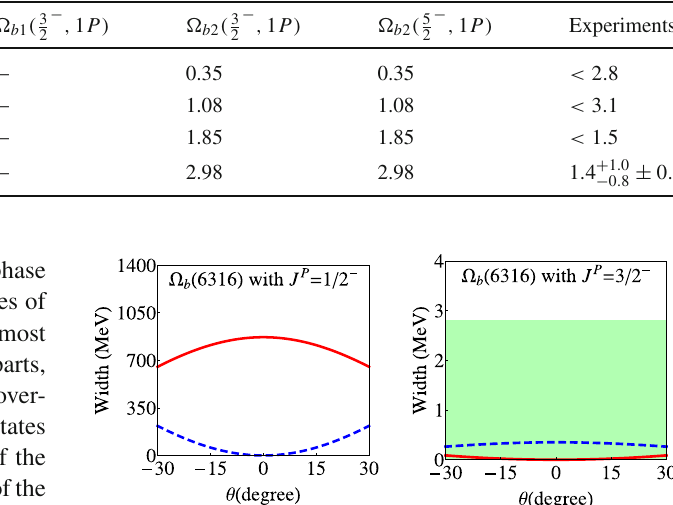
Table 2 The decay widths of the four observed resonances as the (cid:2) b ( 1 P ) states in MeV